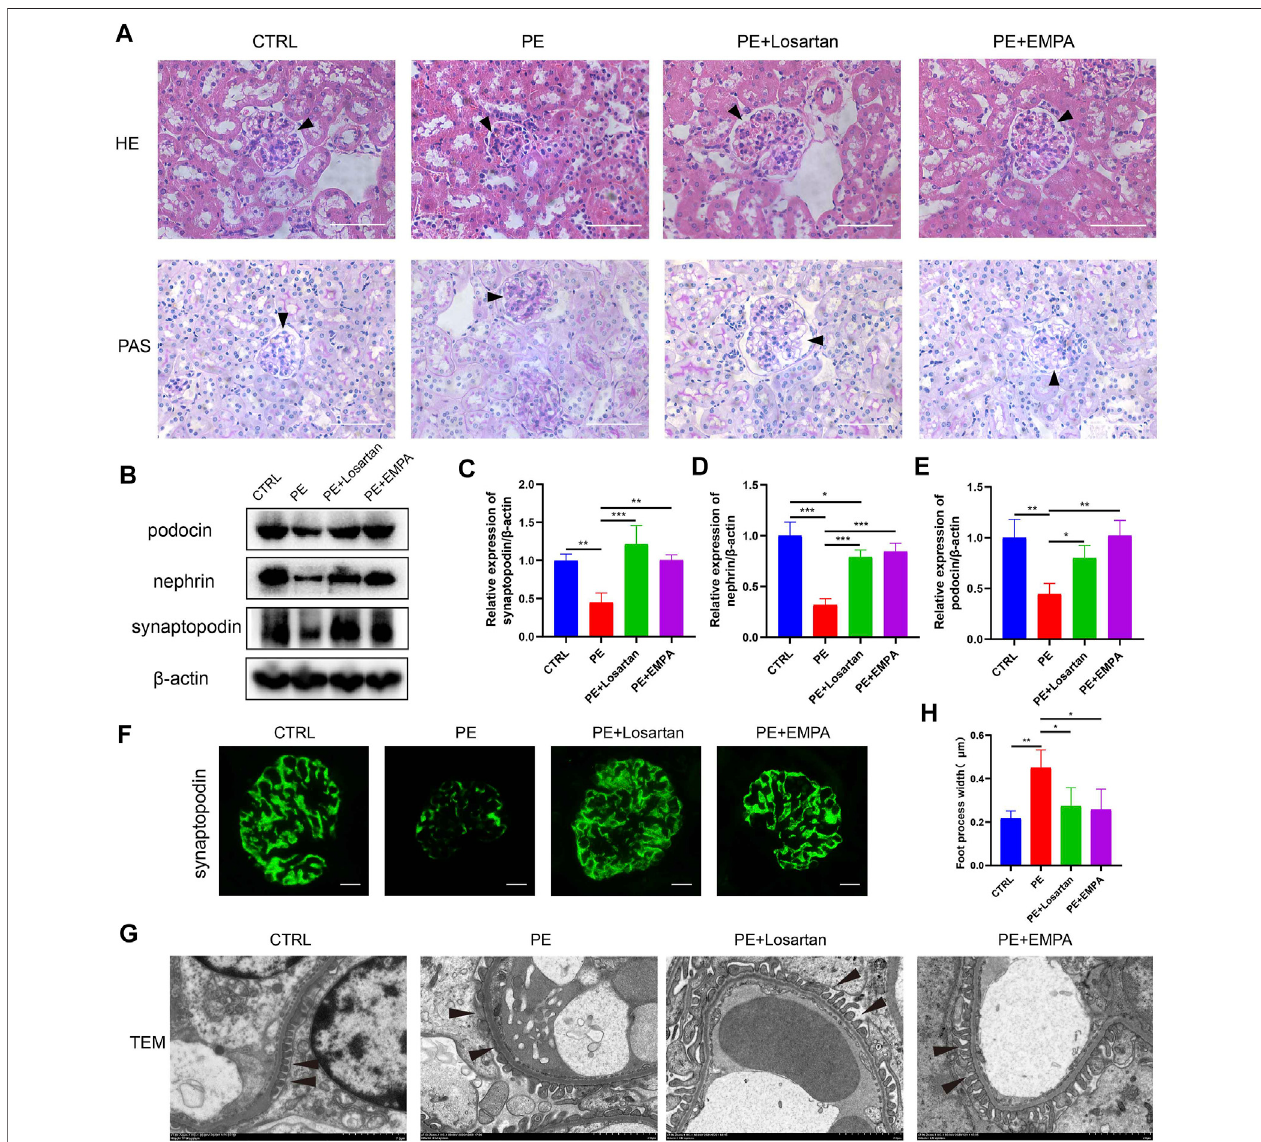
FIGURE 2 | EMPA ameliorated renal injury and podocytopathy in AT1-AA-induced PE mice. (A) Representative hematoxylin-eosin (HE) and periodic acid-Schiff (PAS) images of kidneys from different groups (scale bar represents 50 μ m), Bowman ’ s spaces are indicated by arrowheads. (B) Representative Western blots for synaptopodin,nephrinandpodocinintheglomeruliofkidneysections.SemiquantitativeanalysisofWesternblotsfor (C) synaptopodin( n =3), (D) nephrin( n =3)and (E) podocin ( n = 3). (F) Representative immuno fl uorescence images of synaptopodin in kidneys of different groups. Scale bar: 10 μ m. (G) Representative electron micrographs of glomeruli from control and PE mice treated with vehicle, EMPA or losartan. Podocyte foot processes are indicated by arrowheads. Scale bar: 2 μ m. (H) Quantitative podocyte foot process width ( n = 3). Data are expressed as the mean ± SEM and were analyzed by ANOVA with LSD post hoc test. * p < 0.05, ** p < 0.01, *** p <